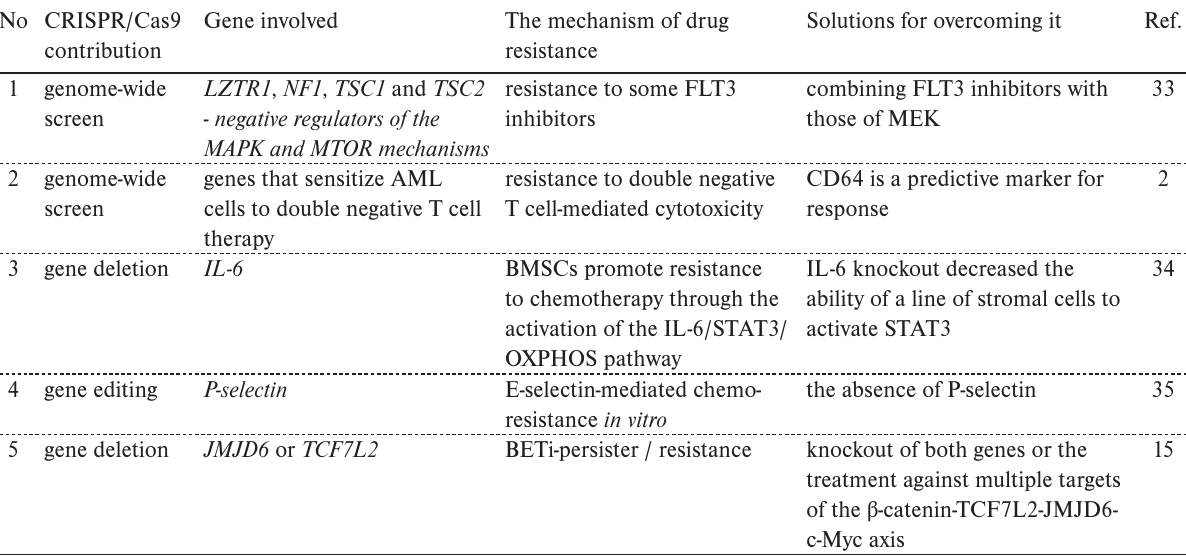
Table 2. The contribution of CRISPR/Cas9 technology to understanding the mechanisms of drug resistance of AML cels and overcoming them. Solutions for overcoming it